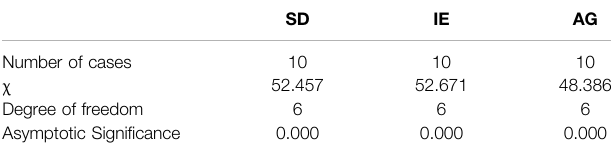
TABLE 7 | Friedman test statistics at Evaluation